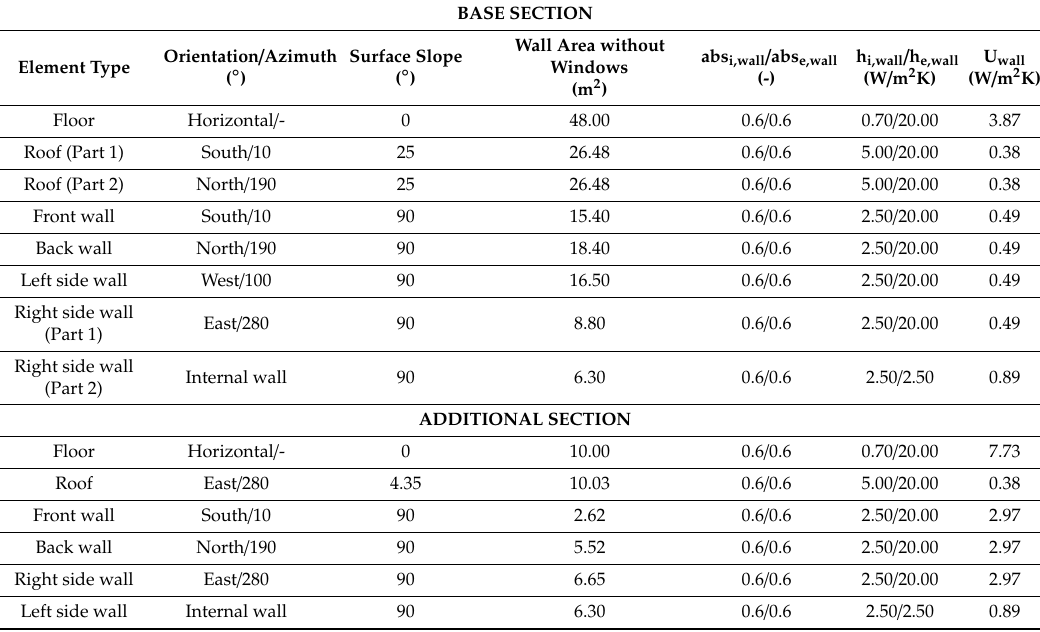
Table 2. The characteristics of the walls of the house.